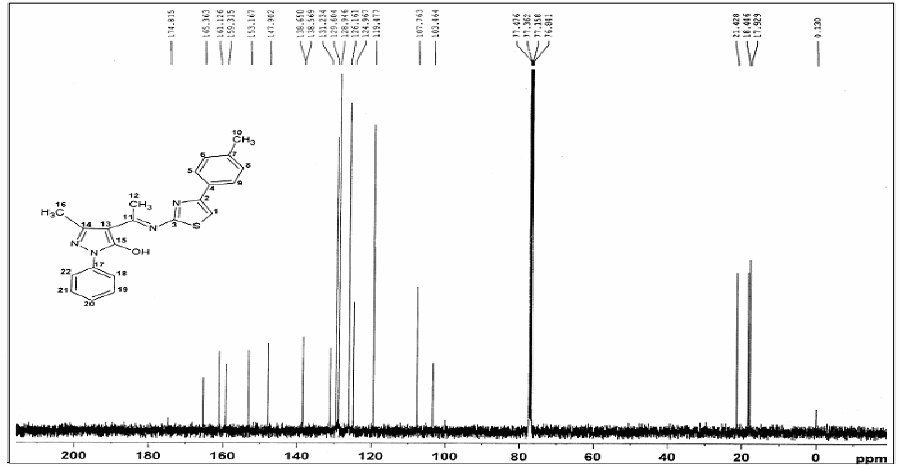
Figure 3. 13 C NMR spectra of AcPMPAMPT